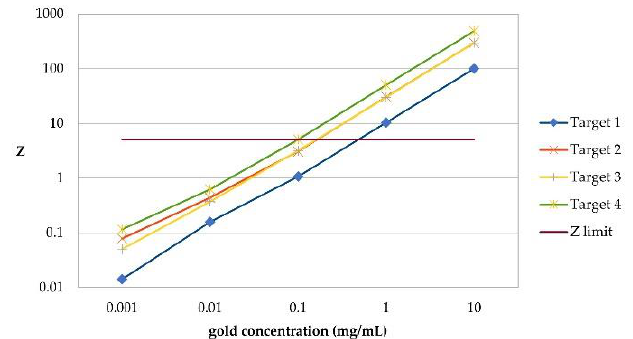
Figure 4. Signal significance ( Z ) per gold concentration for every lung target when scanning thorax. Each target is a group of gold-filled voxels in right lung. Its size increases with its number. For target 2 and 3, scanned volume contains 3 gold-filled voxels, and for target 4 it contains 5, respectively. Significance for Target 2 and 3 differs at lowest gold concentration despite same amount of gold-filled voxels in scanned volume, most likely due to a reduced efficiency of spatial filtering at an overall low significance. Z limit of 5 was defined based on preliminary studies of our research group and is lowest significance at which a signal can be detected above background Here, significance calculated for K β fluorescence after application of spatial filtering algorithm is shown because for K β , a higher significance than for K α could be found.